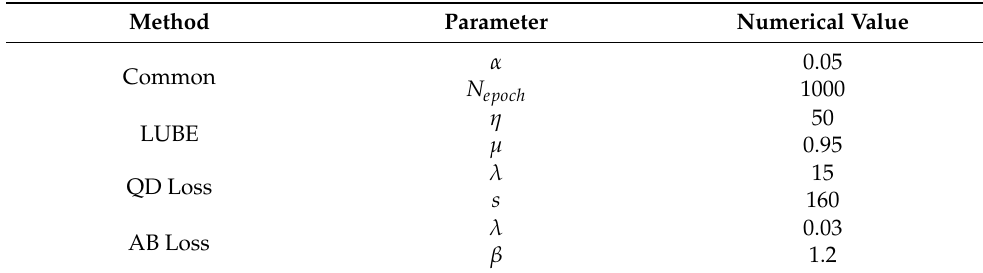
Table 2. Parameters used in the